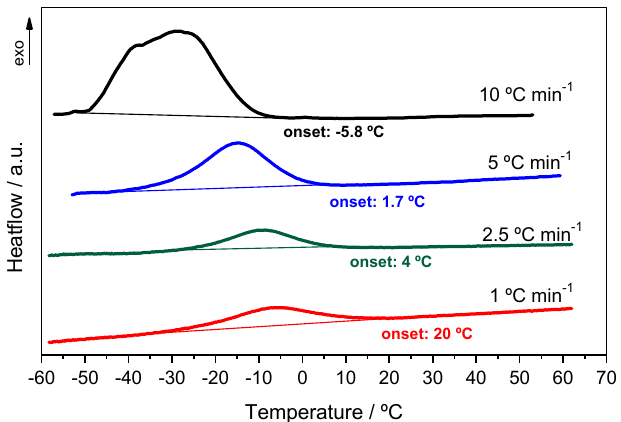
Figure 8. DSC curves corresponding to the γ → ε transformation at four different cooling rates. The onset is related to the Ms temperature.